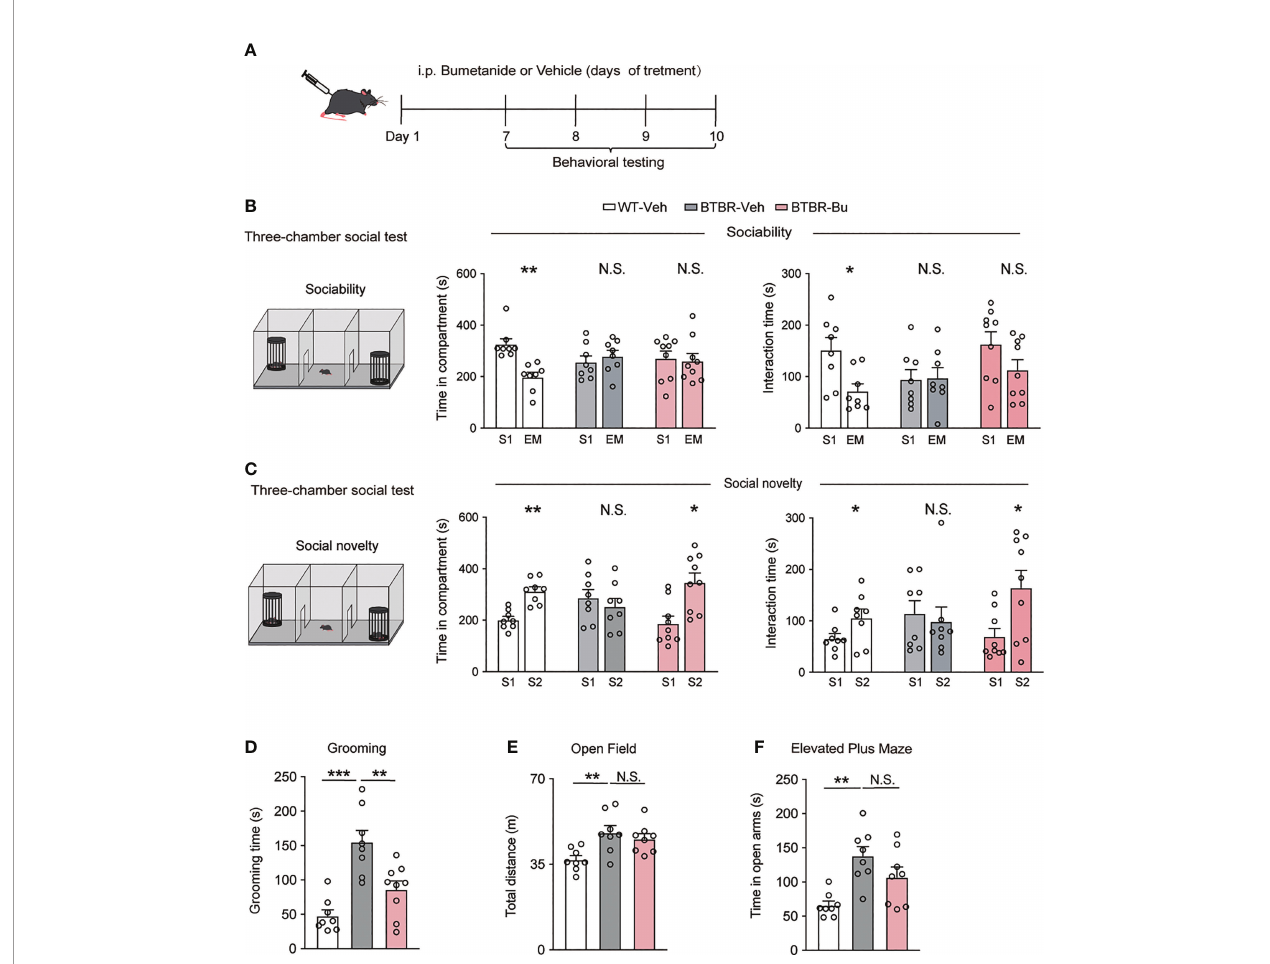
FIGURE 1 | Systemic treatment with bumetanide alleviated autistic-like behavioral in BTBR mice. (A) Schematic representation of the experimental procedure. Male BTBR mice were injected intraperitoneally (i.p.) with bumetanide (10 mg/kg) or vehicle. (B) Time spent in the social stimulus or empty chamber and total interaction time with stimulus mouse or empty wire during sociability stage (WT-vehicle, n = 8; BTBR-vehicle, n = 8; BTBR-bumetanide, n = 9, paired Student ’ s t -test. Time in compartments, ** p < 0.01, WT-vehicle S1 vs. EM; N.S., not signi fi cant, BTBR-vehicle S1 vs. EM; N.S., not signi fi cant, BTBR-bumetanide S1 vs. EM; interaction time, * p < 0.05, WT-vehicle S1 vs. EM; N.S., not signi fi cant, BTBR-vehicle S1 vs. EM; N.S., not signi fi cant, BTBR-bumetanide S1 vs. EM; S1 represent stranger stimuli mouse 1, EM represent empty cage). (C) Time spent in familiar or novel stimulus chamber and total interaction time with familiar or novel stimulus mouse